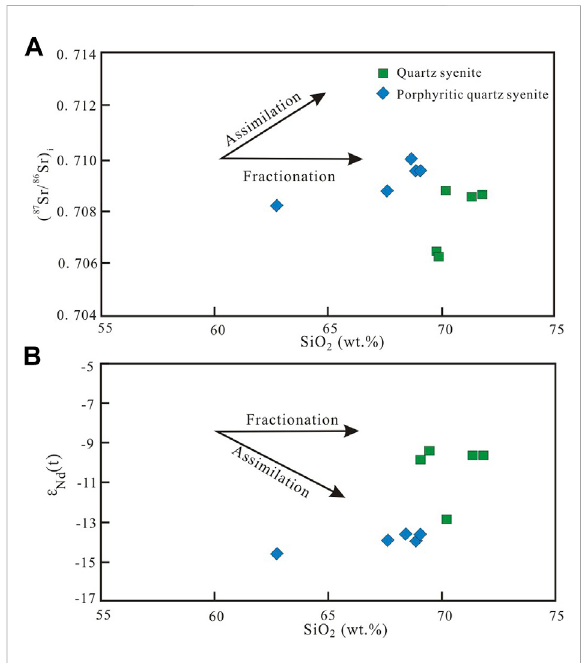
FIGURE 10 Diagrams of initial 87 Sr/ 86 Sr ratio versus SiO 2 (A) and ε Nd (t) valueversusSiO 2 (B)